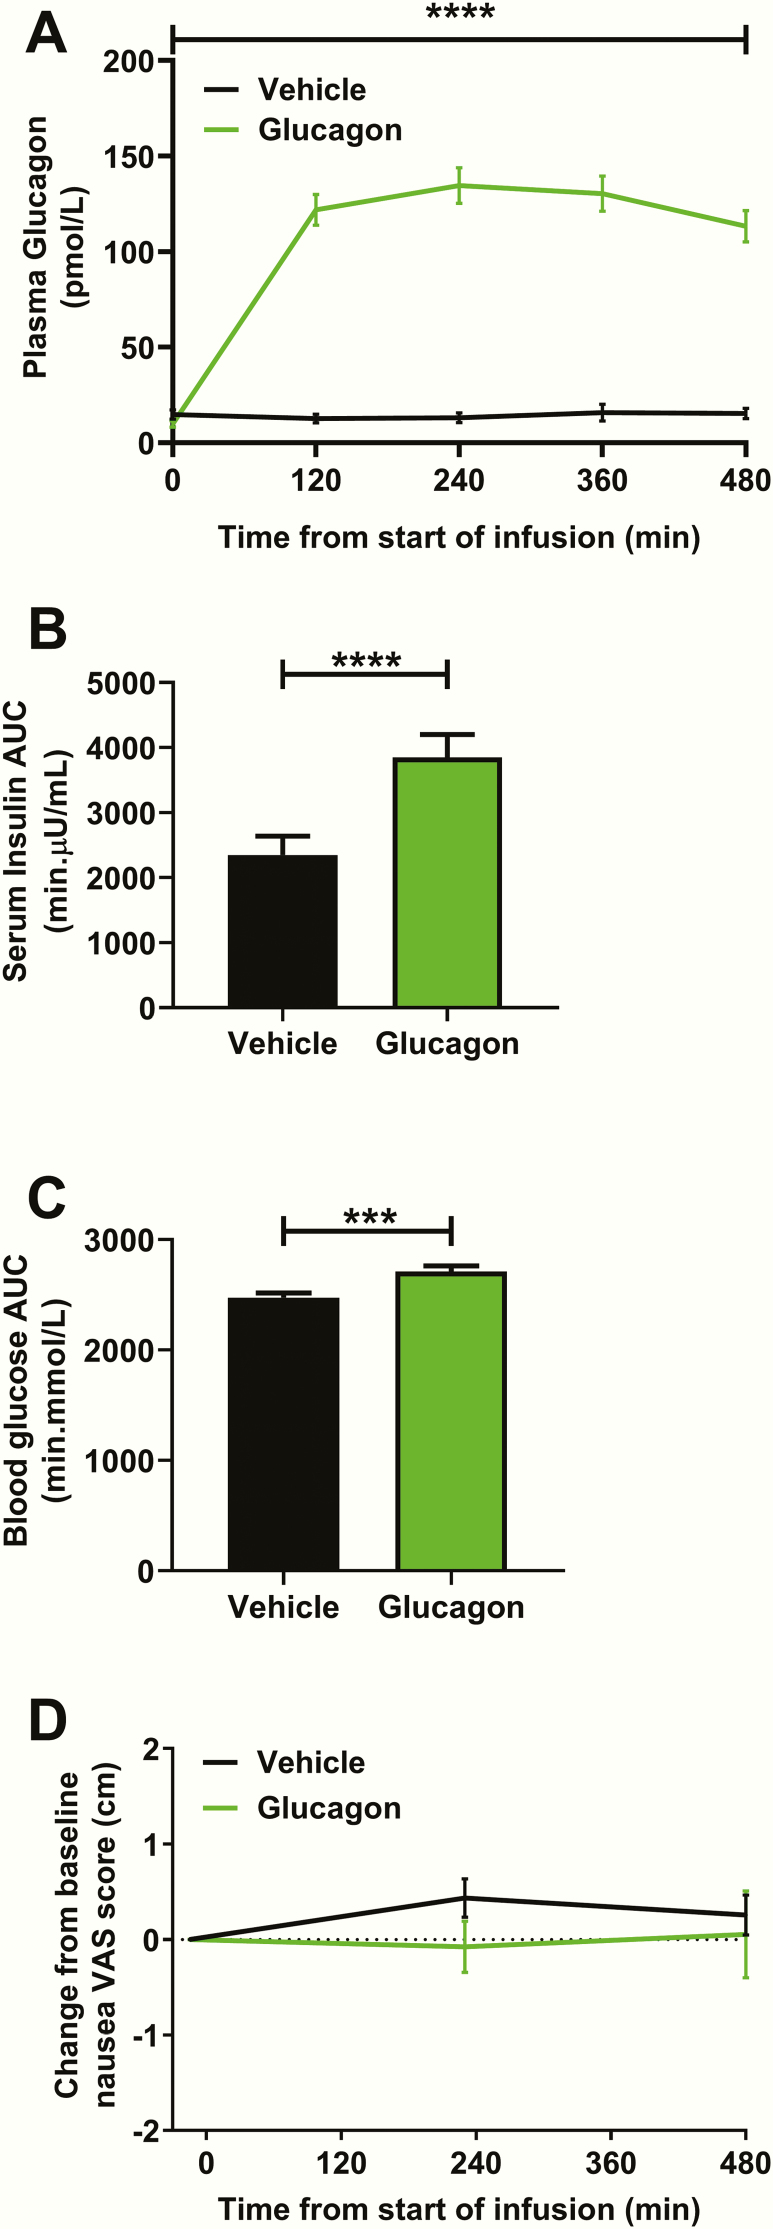
Confirmation of biological activity of administered glucagon. A, Glucagon levels were significantly higher during glucagon administration compared to during vehicle administration (vehicle vs glucagon from T = 0 min to T = 480 min, ****P < .001 using generalized estimating equation [GEE]). B, Insulin area under the curve (AUC) was significantly higher during glucagon administration compared to vehicle administration (****P < .001 using a Wilcoxon matched-pairs signed rank test). C, Glucose AUC was significantly higher during glucagon administration compared to vehicle administration (***P < .001 using a paired t test). D, There was no significant difference in self-reported (change from baseline) nausea during glucagon administration compared with vehicle administration (vehicle vs glucagon from T = –15 min to T = 470 min, P = .32 using GEE). Abbreviation: VAS, visual analog scale (0-10 cm).